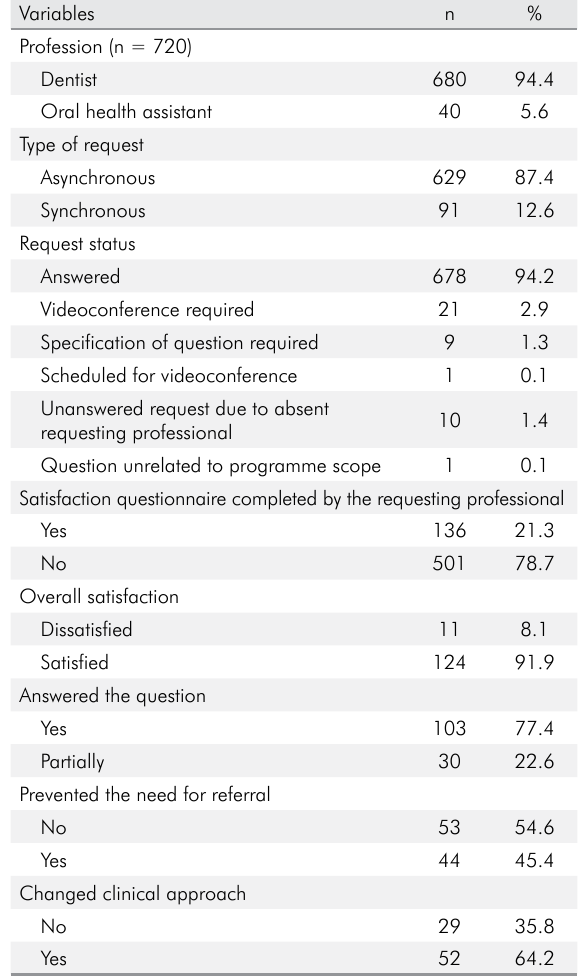
Table 4. Description of the impact of teleconsultations on the professional approach of dentists and oral health assistants who requested two or more